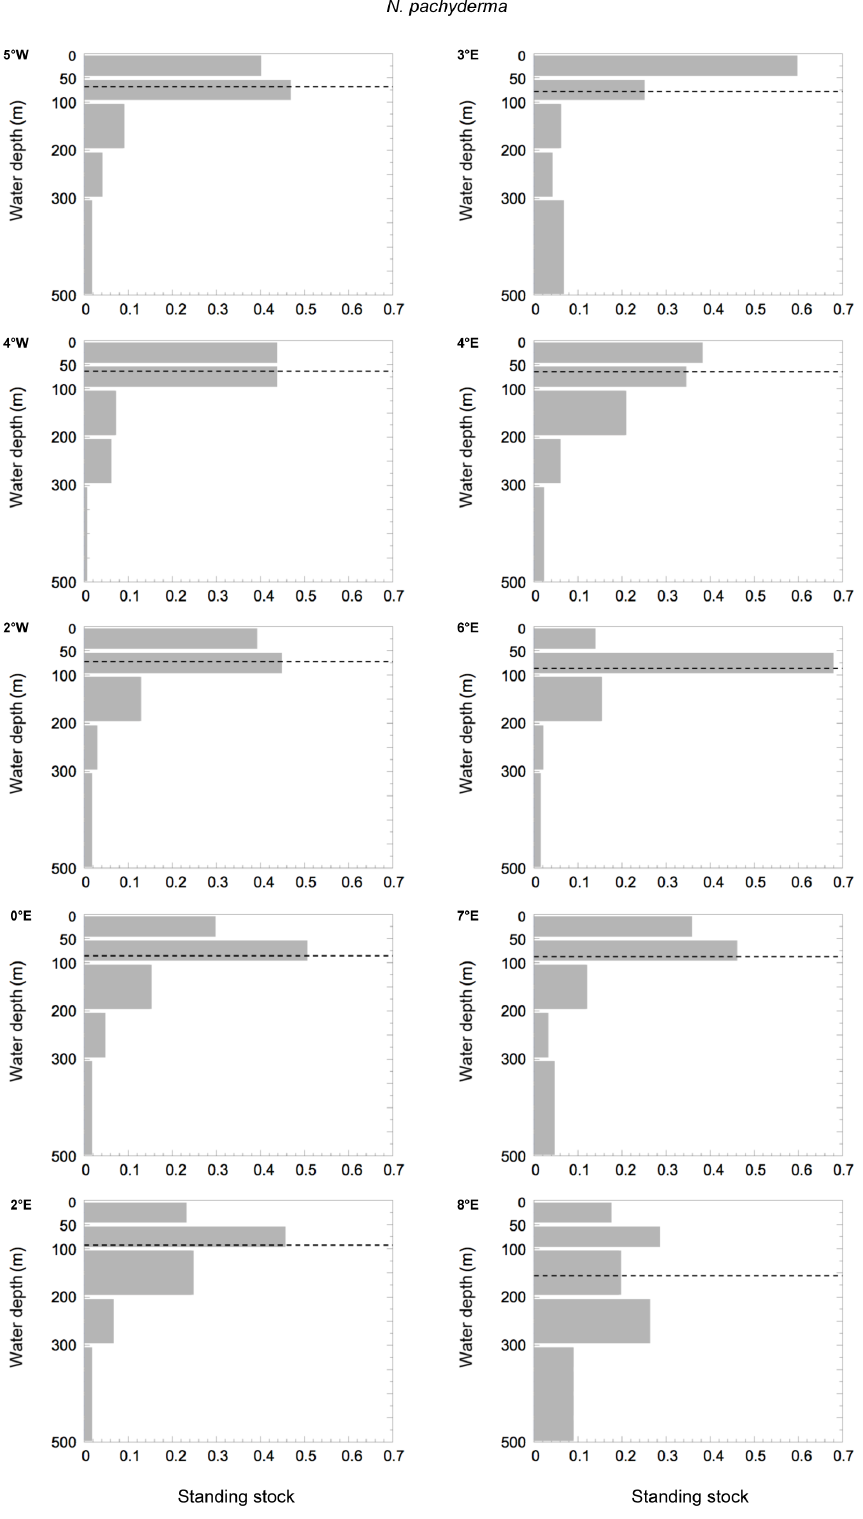
Figure 6. Standing stock of N. pachyderma for each sampling interval. The black dashed line indicates the average depth of calcification (calculated from the standing